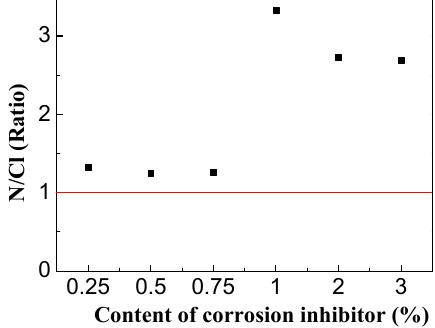
Figure 13. Corrosion inhibitor and Cl-content.